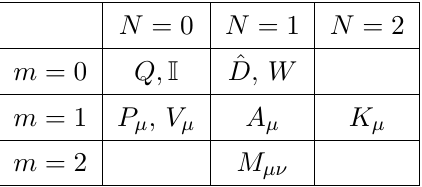
Table 2 . This table summarizes all super(cid:13)uid symmetries organized in powers or x N and the number m of Lorentz indices (not irreps). Commuting with spacetime translations move us leftward along a